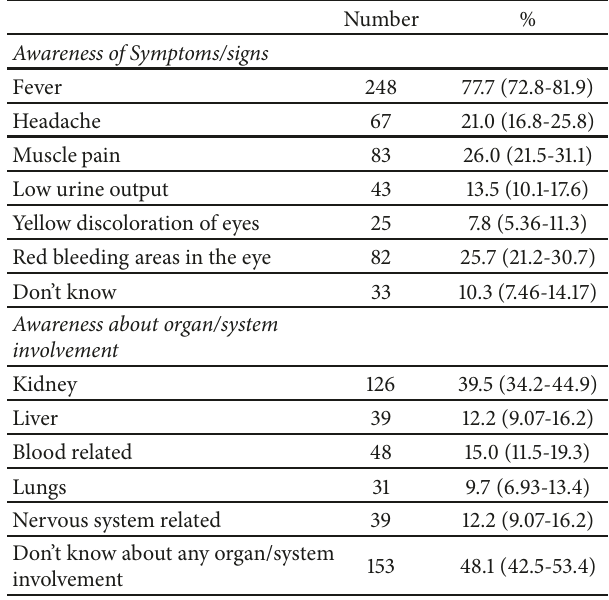
Table 2: Knowledge about the main clinical features and organ involvement in leptospirosis among farmers: frequency of how much people knew about each parameter.